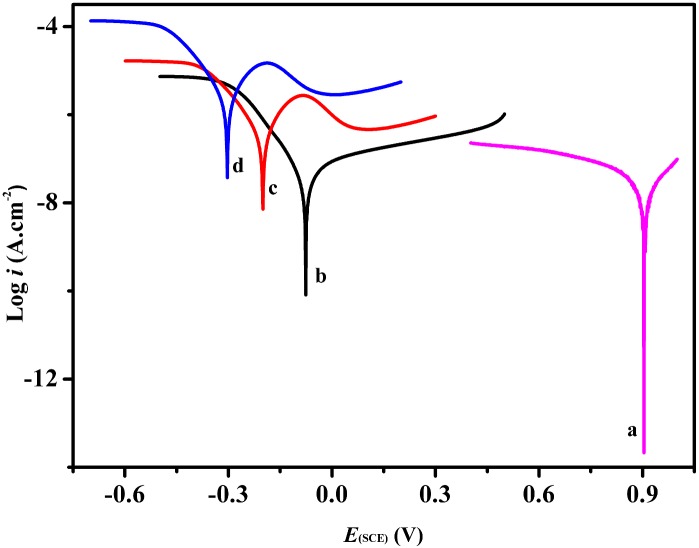
Tafel polarization curves of CuS-GeO2-TiO2 composite coating electrode. (a) Pure TiO2, (b) Dark, (c) Visible light, and (d) Ultraviolet light.